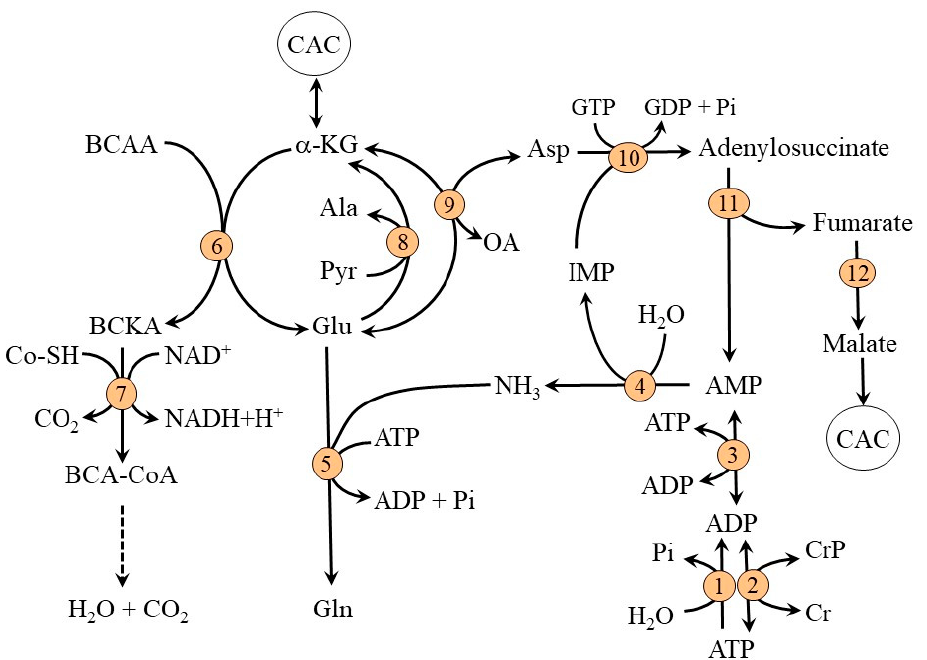
Figure 1. Ammonia synthesis and detoxification to glutamine in muscles. 1, ATPase; 2, creatine kinase; 3, adenylate kinase (myokinase); 4, AMP deaminase; 5, glutamine synthetase; 6, BCAA aminotransferase; 7, BCKA dehydrogenase; 8, ALT; 9, AST; 10, adenylosuccinate synthetase; 11, adenylosuccinate lyase; 12, fumarase. BCAA, branched-chain amino acids; BCA-CoA, branched-chain acyl-CoA; CAC, citric acid cycle; Cr, creatine; CrP, creatine phosphate; IMP, inosine monophosphate; OA, oxaloacetate; Pi, inorganic phosphate.